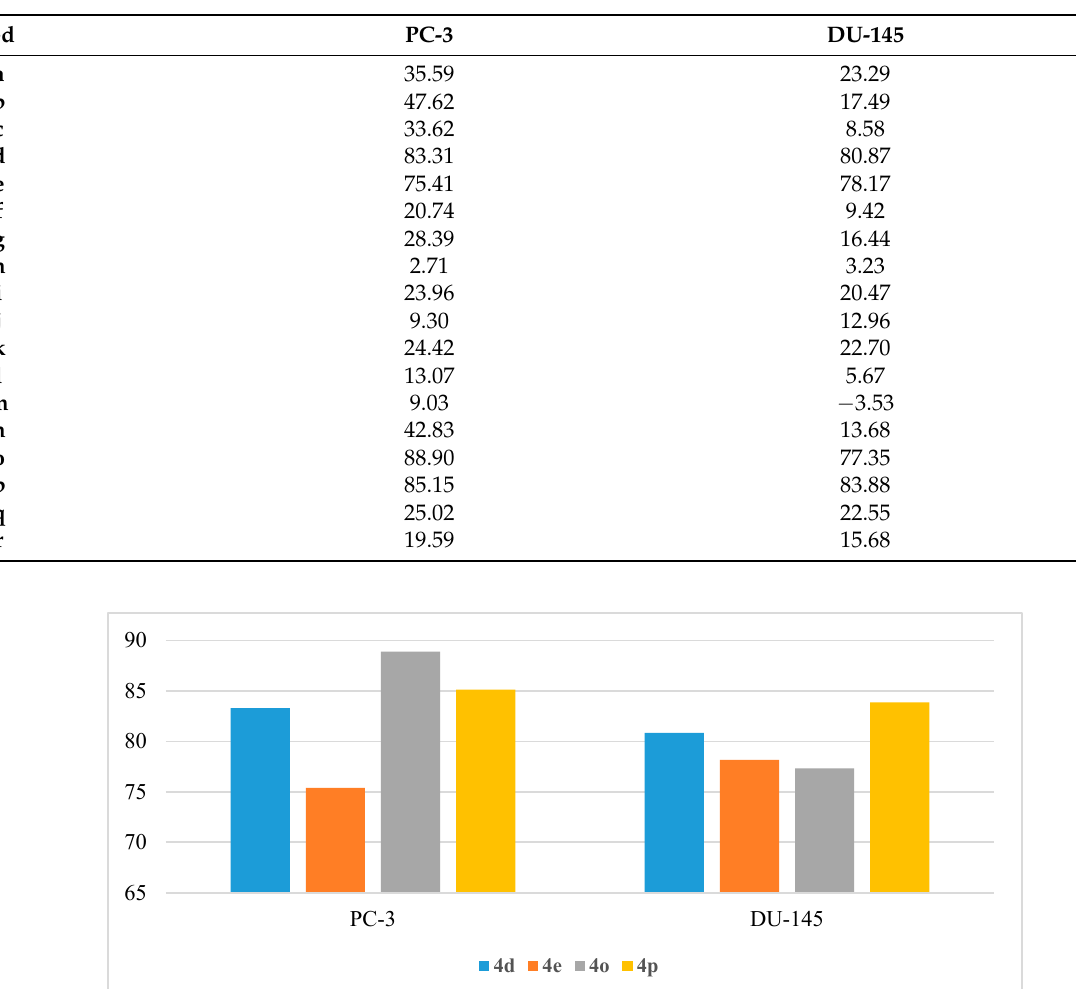
Table 12. Anti-proliferative activities (% growth inhibition) of the target compounds 4a - r against prostate cancer cell lines.